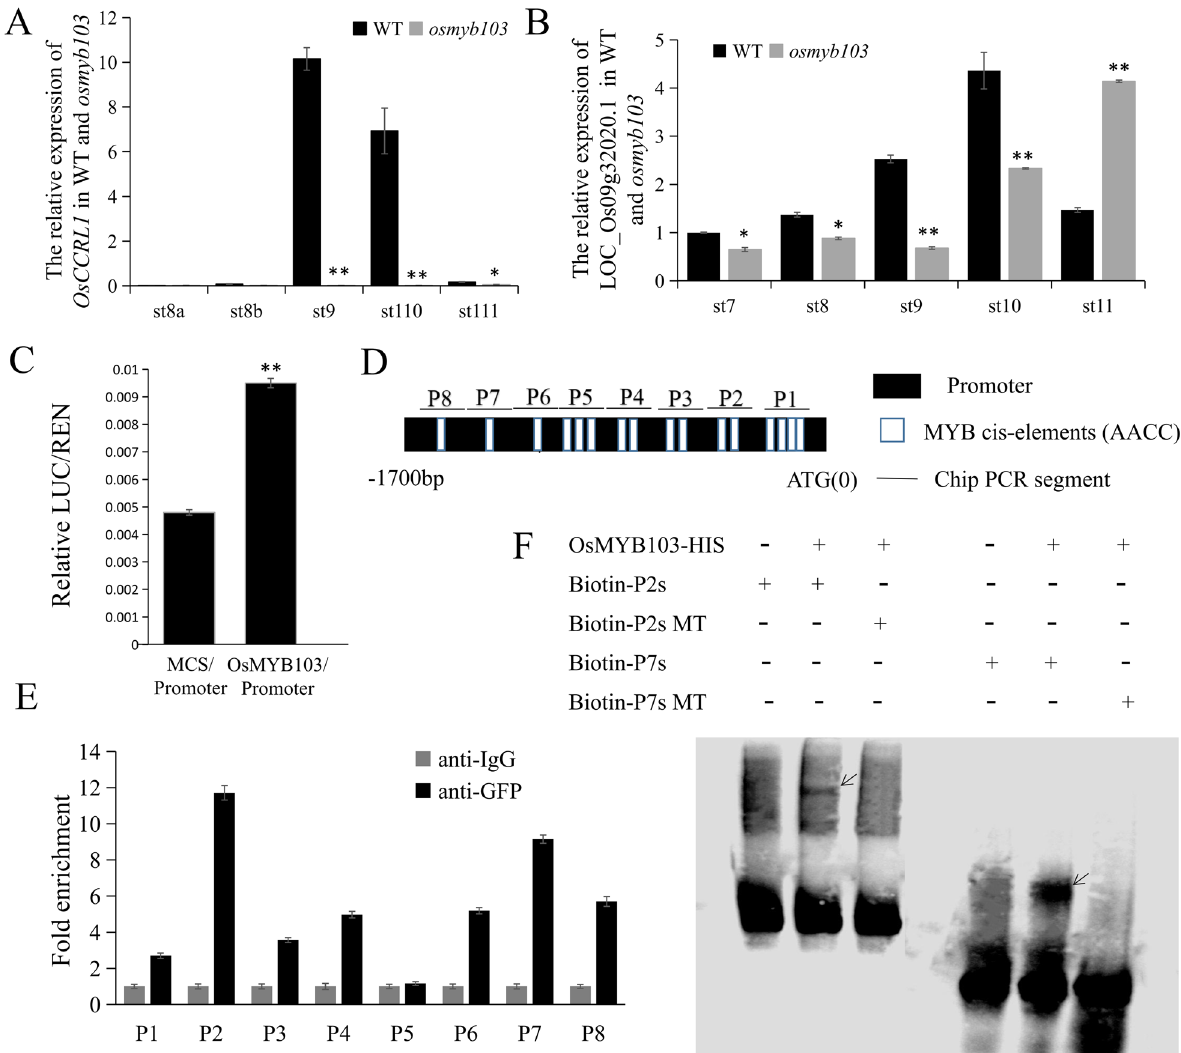
Fig. 6 OsMYB103 regulates the expression of OsCCRL1. A , B The relative expression comparison of OsCCRL1 and LOC_Os09g32020.1 between the wild-type and osmyb103 mutant anthers. Data are means SD ( n 3). Asterisks indicate the significance differences determined by Student’s t-test ± = (*, 0.01 P < 0.05; **, P < 0.01). C Transient expression assay of the LUC reporter gene with the multiple cloning site (MCS) effector plasmid using as ≤ a control. Data are means SD ( n 3). Asterisks indicate the significance differences determined by Student’s t-test (*, 0.01 ± = D Schematic diagrams of the distribution of ‘AACC’ motifs ( cis -elements recognized by OsMYB103 transcription factors) in the OsCCRL1 promoter regions. E A ChIP-qPCR analysis of OsMYB103 binding the ‘AACC’ motifs to OsCCRL1 promoter regions in Ubi::OsMYB103-GFP plants with anti-GFP antibody. Data are means SD ( n 3). F An EMSA assay of OsMYB103 protein directly binding to the probe ‘P2s’ (93 bp) and ‘P7s’ (40 bp) of OsCCRL1 ± = promoter. ‘Biotin-P2s mutant’ and ‘Biotin-P7s mutant’ mean the mutant probes at ‘AACC’